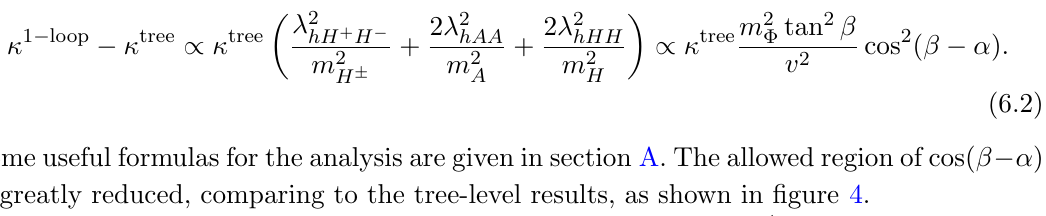
Figure 4 . Allowed region from two-parameter (cid:12)tting results at 95% C.L. in the cos( (cid:12) plane under CEPC Higgs precision measurements at one-loop level for m (cid:8) = 800 GeV and p (cid:21)v 2 = 300 GeV. The red region is the (cid:31) 2 (cid:12)t result with the best (cid:12)t point indicated by the black star (near (cid:11) ) = 0). As a comparison, the black dashed line shows the allowed region at tan (cid:12) = 50 and cos( (cid:12) (cid:0) tree level. Regions enclosed by curves of di(cid:11)erent colors indicate the domains allowed by individual coupling measurements. The grey shadow area indicates the theoretically favored